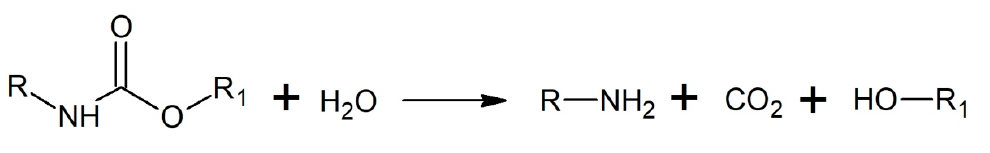
Figure 4. Polyurethane hydrolysis.